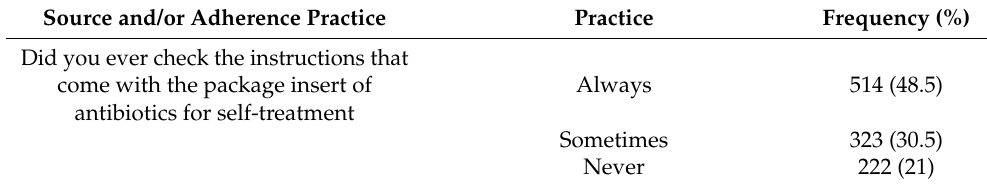
Table 5. Knowledge, practice, and adherence to dosage of antibiotics and/or